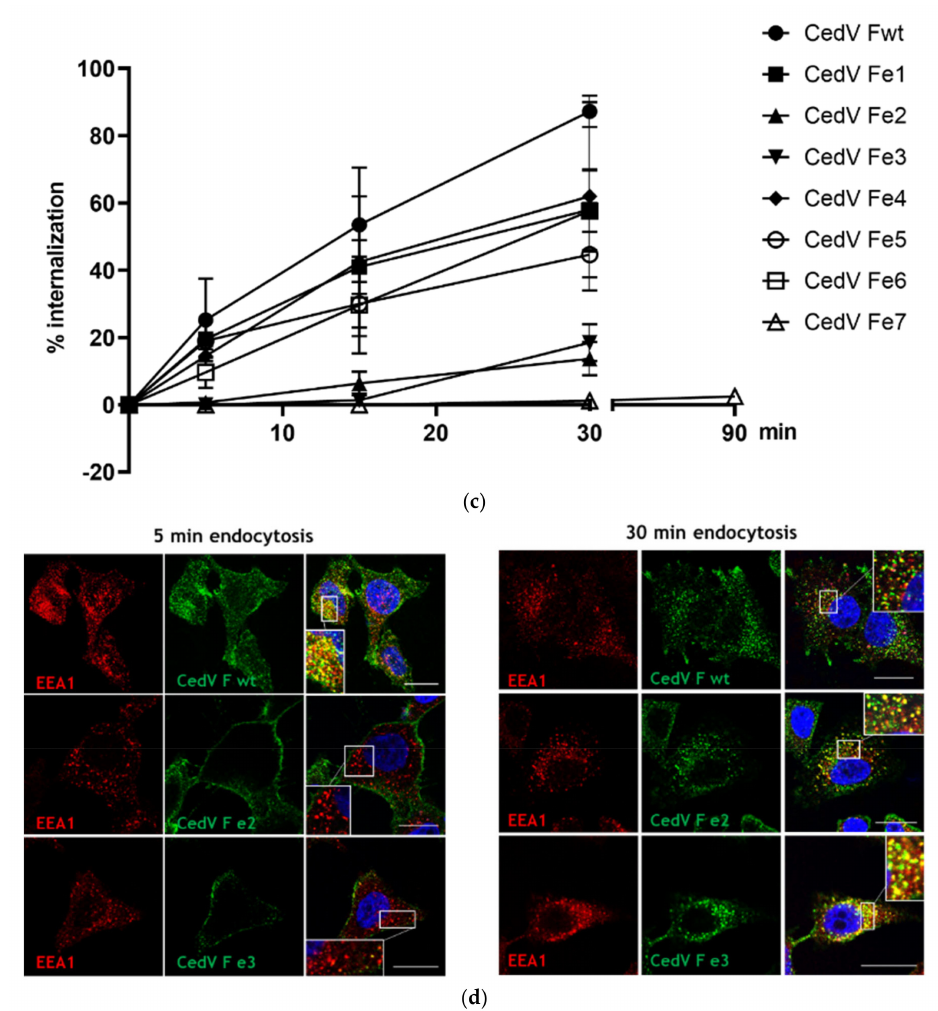
Figure 4. Endocytosis of CedV F proteins in MDCK-2 cells. ( a ) Antibody uptake assay of mutant CedV F proteins. MDCK-2 cells were transfected with plasmids encoding the indicated CedV F protein mutants. At 24 h p.t., a CedV F-specific rabbit antiserum was used to label surface-expressed F proteins at 4 ◦ C. Then, the cells were shifted to 37 ◦ C for 30 min to allow endocytosis to occur. AF 488-conjugated secondary antibodies visualized surface-bound primary antibodies. After fixation and permeabilization, AF 568-conjugated secondary antibodies were used to stain internalized primary antibody-CedV F protein complexes. Magnification, × 60. n = 2. ( b ) At 24 h p.t., CedV F-expressing cells were surface-labeled with cleavable NHS-SS biotin at 4 ◦ C followed by a shift to 37 ◦ C for the indicated times allowing endocytosis to occur. Residual biotin was then cleaved from the cell surface using MESNA. To quantify the amount of surface-biotinylated proteins that underwent endocytosis in a certain time, samples were compared to the total amount of surface-biotinylated control cells